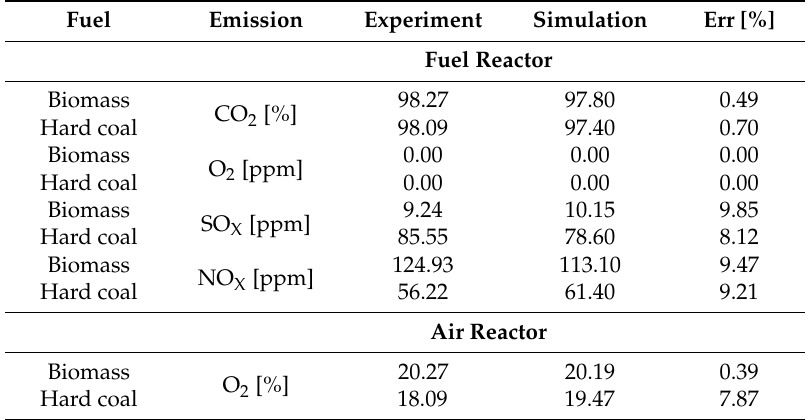
Table 3. Experiment and simulation results concerning emissions in the AR and FR.